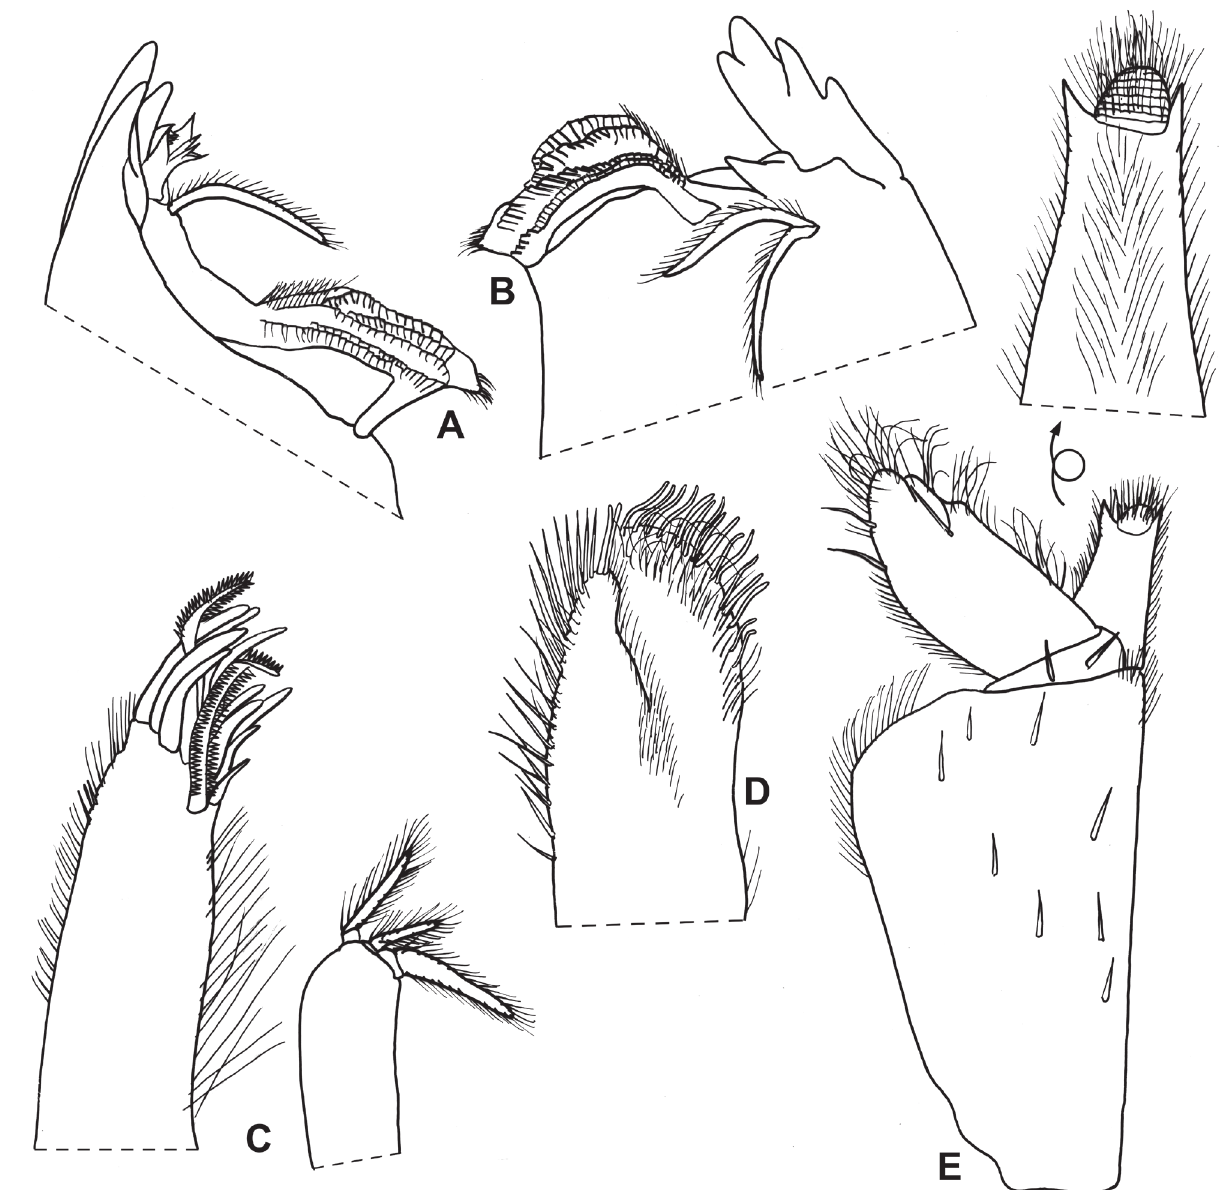
Figure 3. Xangoniscus odara n. sp. (male paratype). A, right mandible; B, left mandible; C, maxillula; D, maxilla; E,